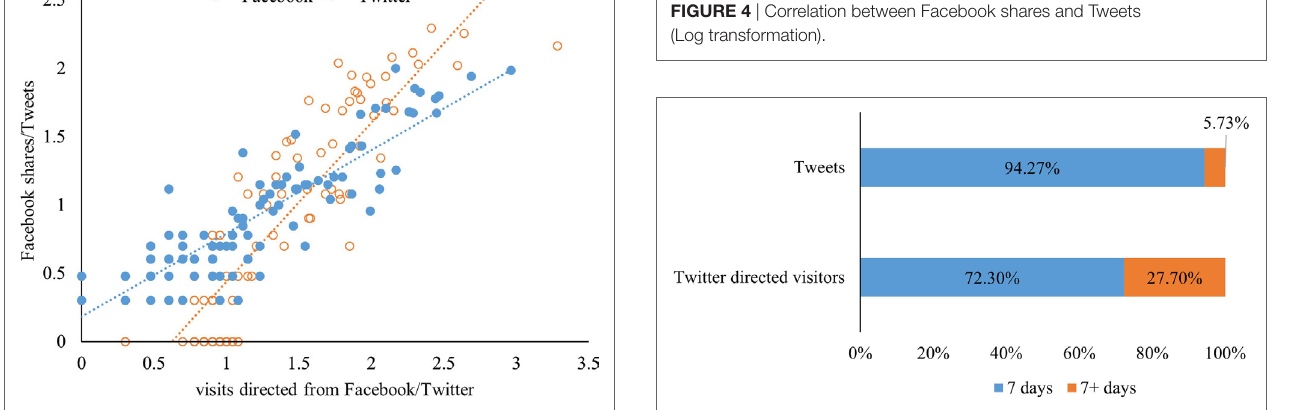
FigUre 5 | Distribution of total tweets and total Twitter directed visitors in two periods after publication.